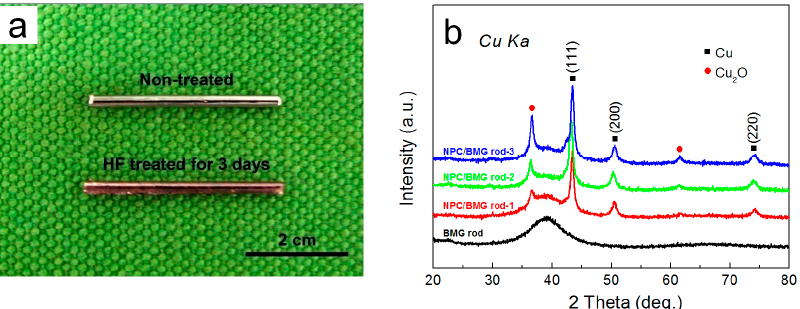
Figure 1. ( a ) Photos (scale bar, 2 cm) and ( b ) X-ray diffraction (XRD) patterns of precursor Cu 50 Zr 45 Al 5 alloys rods before and after dealloying in 0.05 M HF solution for 1, 3 and 5 days at 298 K, respectively.